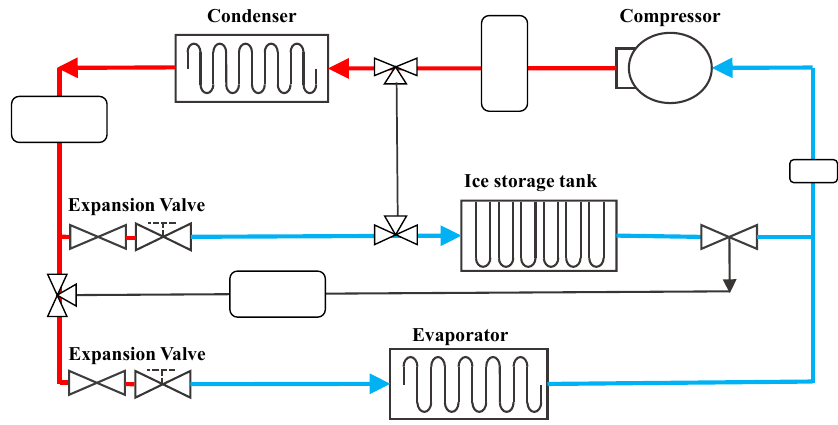
Figure 4. Schematic of the ice storage